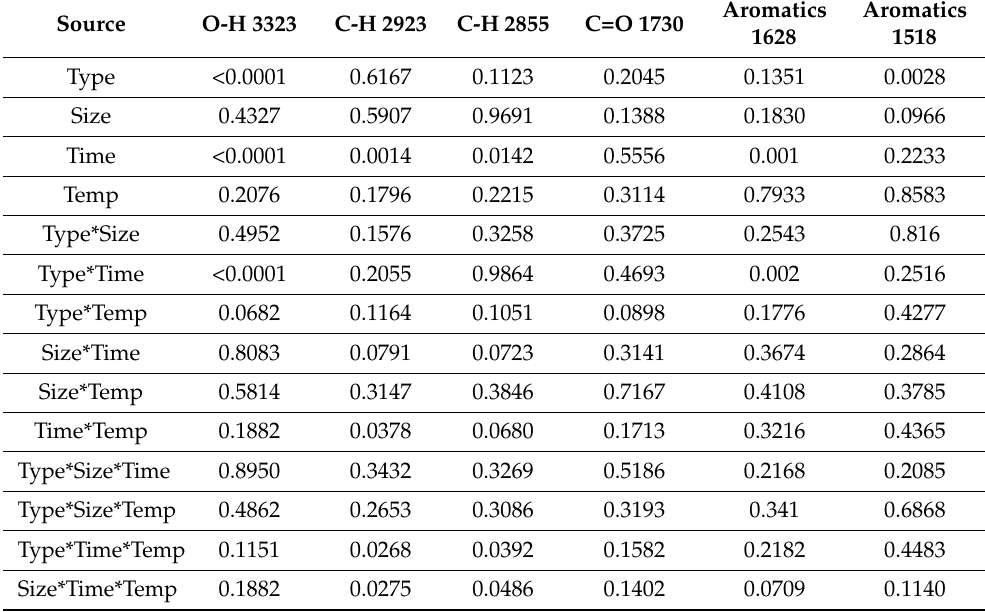
Table 6. Summary of F-value significance based on ANOVA for physical and thermal pretreatment at 3314, 2920, 2853, 1732, 1633 and 1517 cm − 1